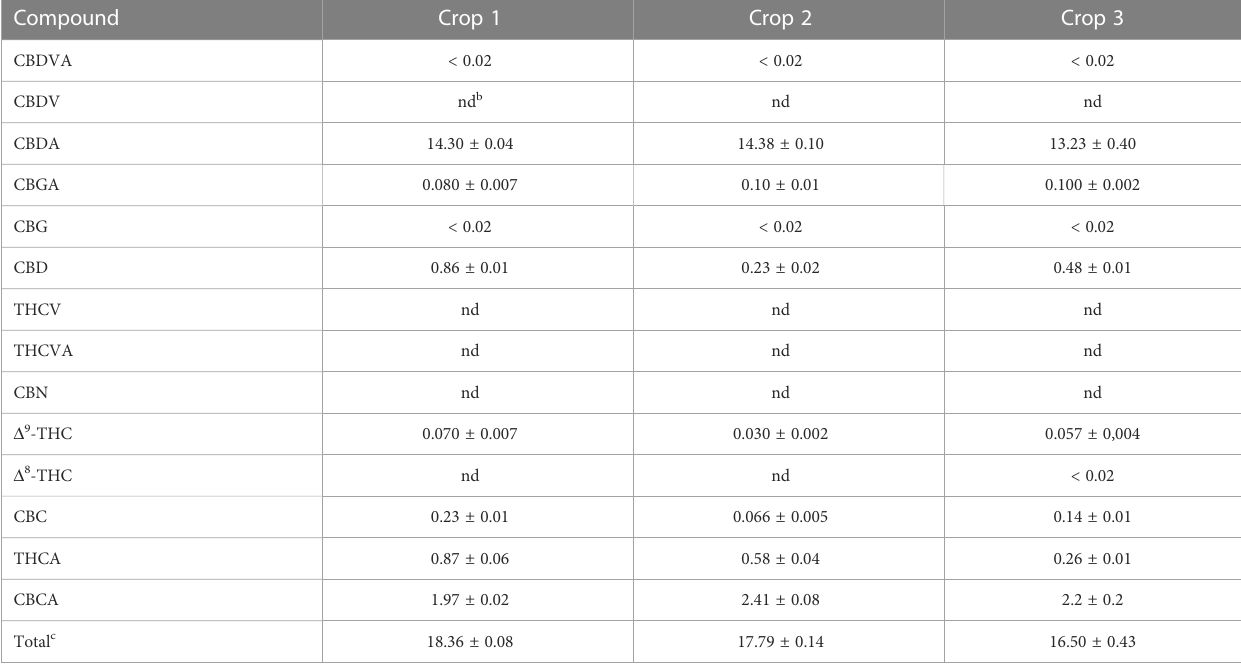
TABLE 2 Composition of chemovar B plant material (mean ± SD) a